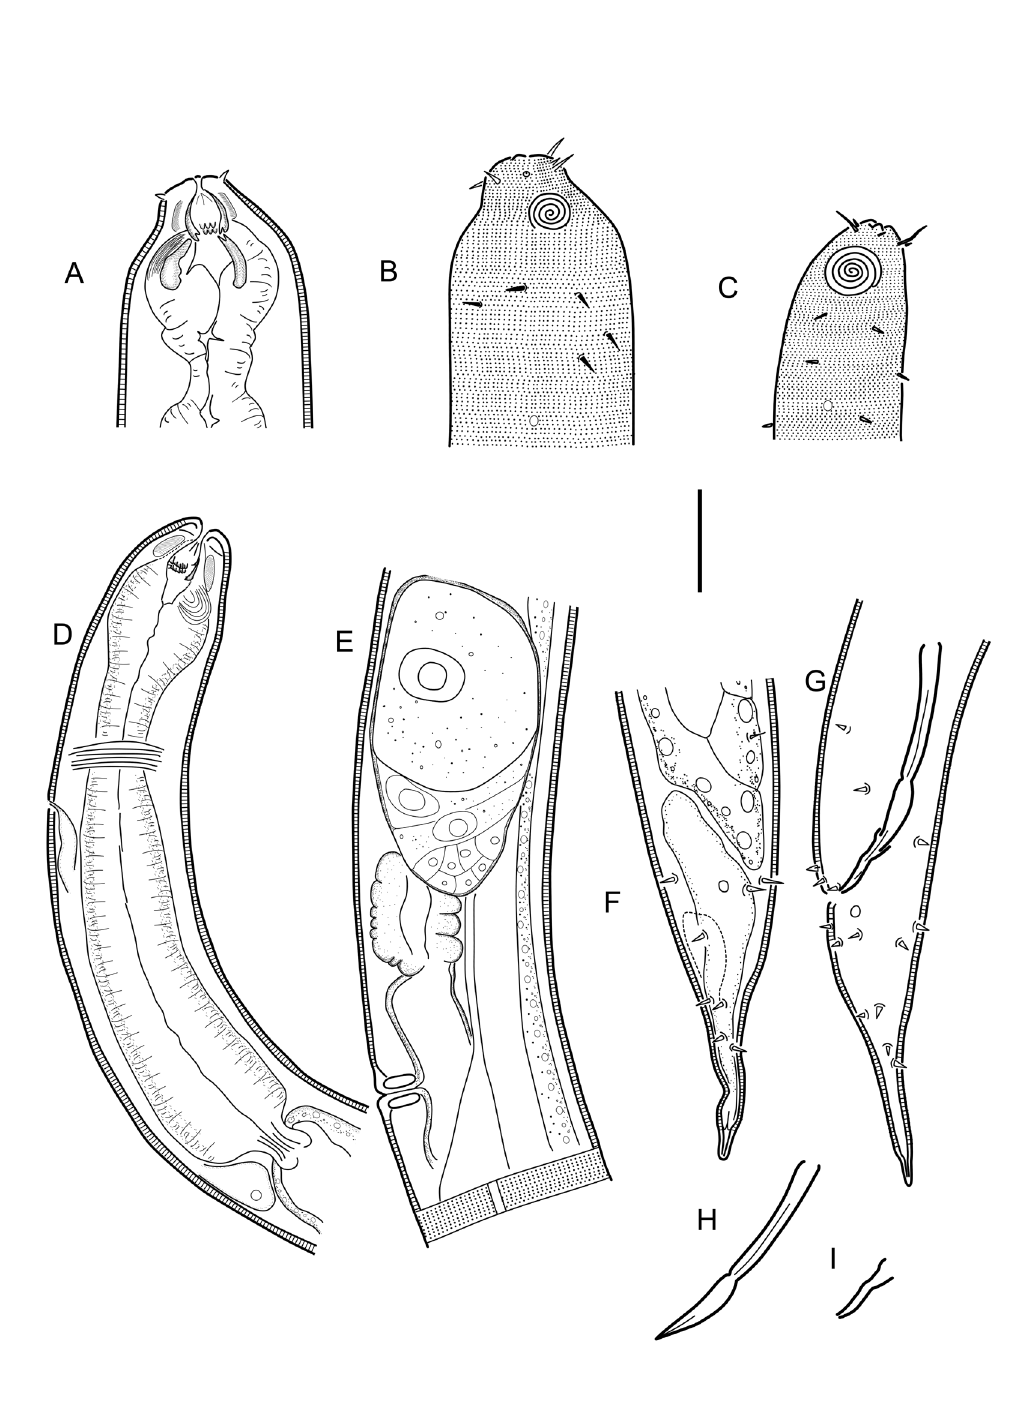
Fig. 2. Cobbionema acrocerca Filipjev, 1922. A . Female head region (ventral side to the right) (SMNH- 179223). B . Surface view of female head (ventral side to the right) (SMNH-179223). C . Surface view of male head (ventral side to the left) (SMNH-179217). D . Anterior part of male (ventral side to the left) (SMNH-179217). E . Female mid-body region showing anterior branch of the reproductive system and lateral ala (SMNH-179216). F . Female caudal region (SMNH-179216). G . Male caudal region (SMNH- 179217). H . Spicule. I . Crura. Scale bar = 20